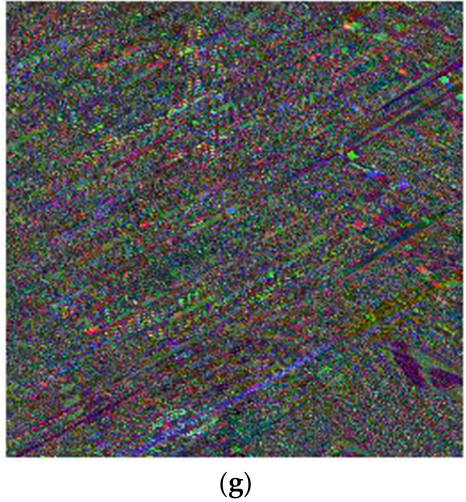
Figure 7. Experimental data: ( a – c ) original image of 30th, 70th and 100th band; ( d – f ) corresponding decrypted image with k = 2; ( g ) decrypted image combined of ( d – f ). Attacker-2 has obtained all of the keys, except the number of triangular association encryptions. He assumes that a = 2 and Figure 8 shows the decrypted image. Attacker-2 cannot obtain any information about the original text from the Figure 8a–d.